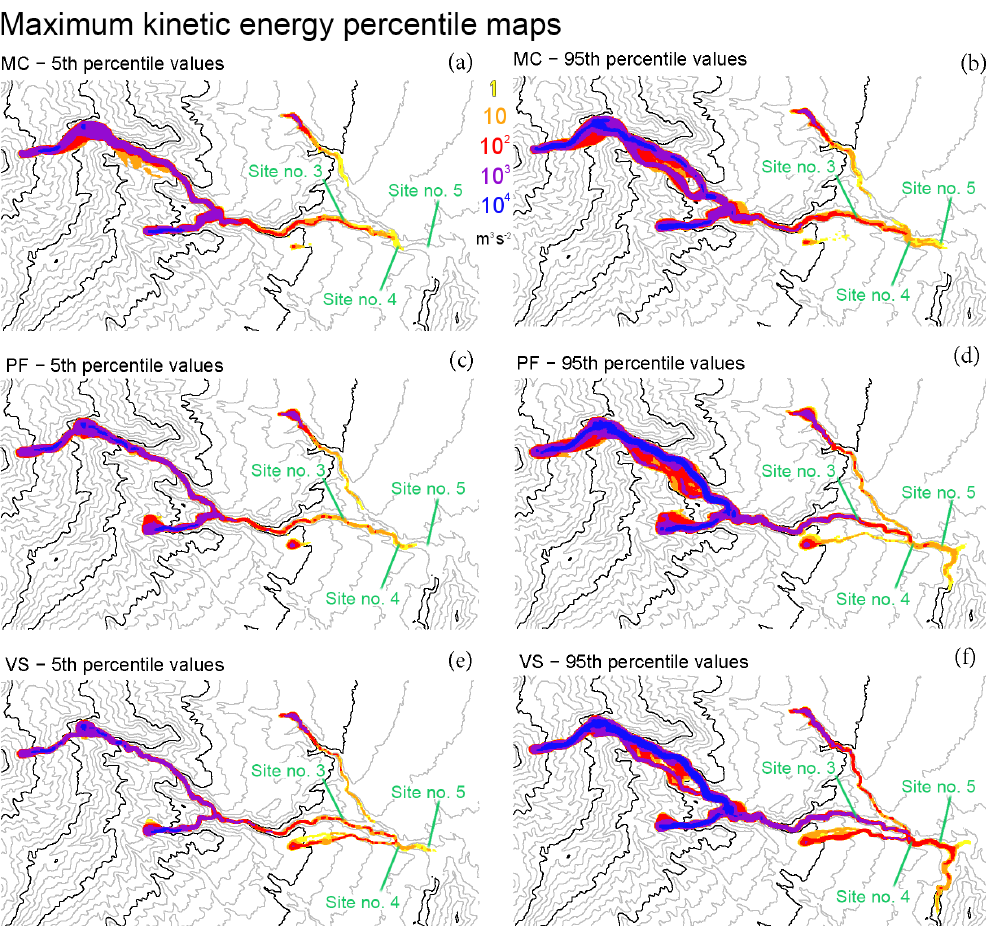
Figure 8. Maximum kinetic energy K as a function of time in (a, b) MC, (c, d) PF, and (e, f) VS models. Panels (a, c, e) are the 5th and (b, d, f) are the 95th percentile values with respect to P j . Colors are related to the energy in logarithmic scale. Elevation contours are included at intervals of 100m (gray) and 500m (black) (NASA – JPL, 2014). Sites 3–5 are